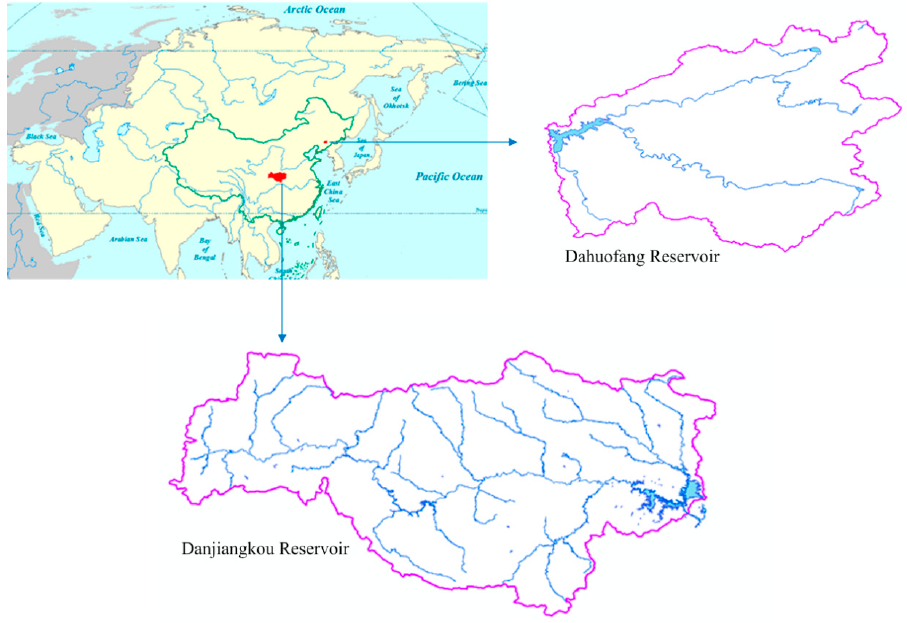
Figure 2. Location of the Dahuofang Reservoir Basin and the Danjiangkou Reservoir Basin in China.